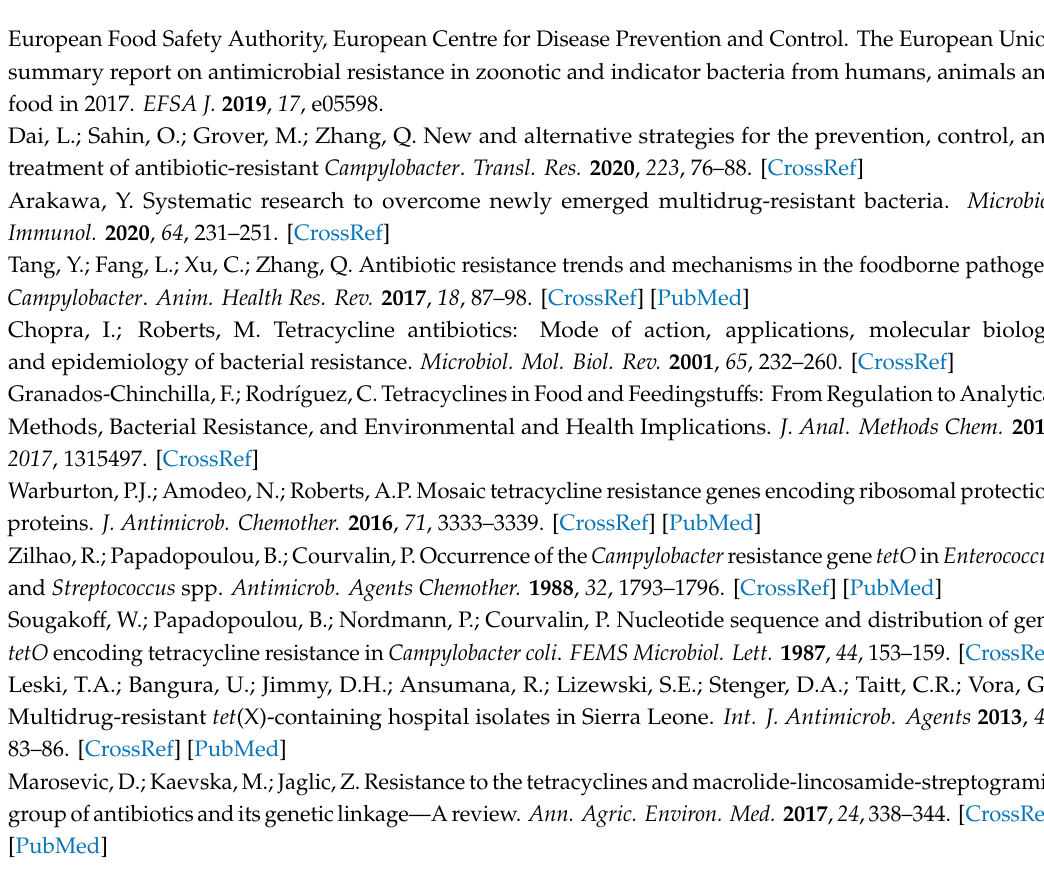
Table S1: Tetracycline phenotype and genotype of Campylobacter